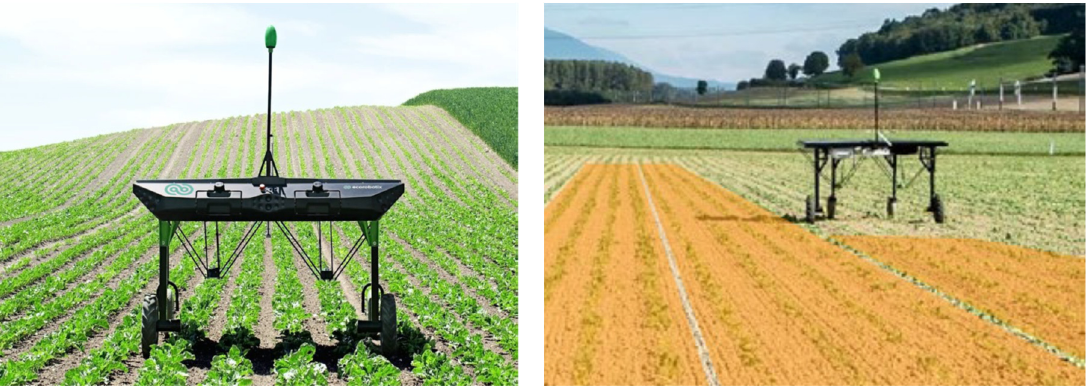
Figure 2. Solar-powered weeders [64].